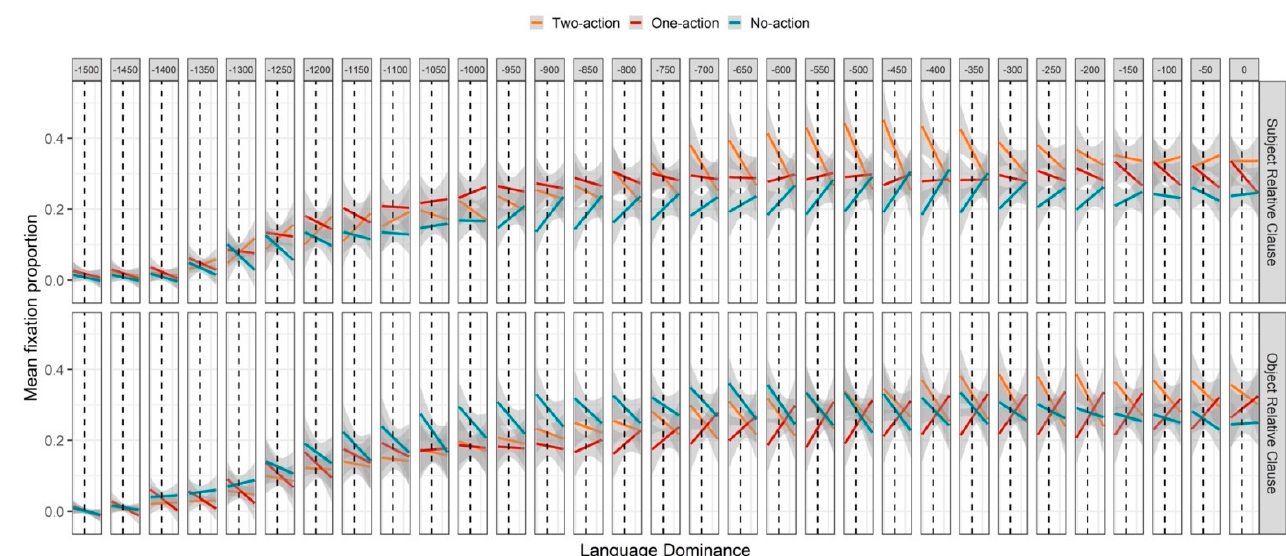
Figure 4. Mean fixation proportions in each 50 ms time window across the anticipation region, as a function of image type, sentence type, and language dominance, where positive values represent Spanish dominance, and negative values represent English dominance. The vertical dashed lines index a dominance score of zero (by hypothesis, balanced bilingualism). Orange lines represent fixation proportions toward the two-action image, red lines represent fixation proportions toward the one-action image, and turquoise lines represent fixation proportions toward the no-action image, while line slopes depict the effects of language dominance. Gray shading around the lines represents the standard error of the mean for the linear effect calculated for each individual 50 ms time window.